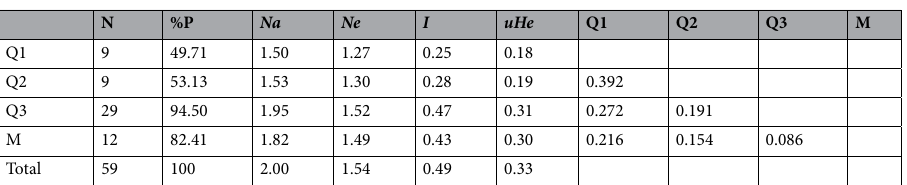
Table 2. Diversity indices estimated for each STRU CTU RE group and Pairwise Fixation index ( Fst ) between them. N sample size, %P percentage of polymorphic loci, Na number of alleles, Ne number of effective alleles, I Shannon’s information index, uHe unbiased expected